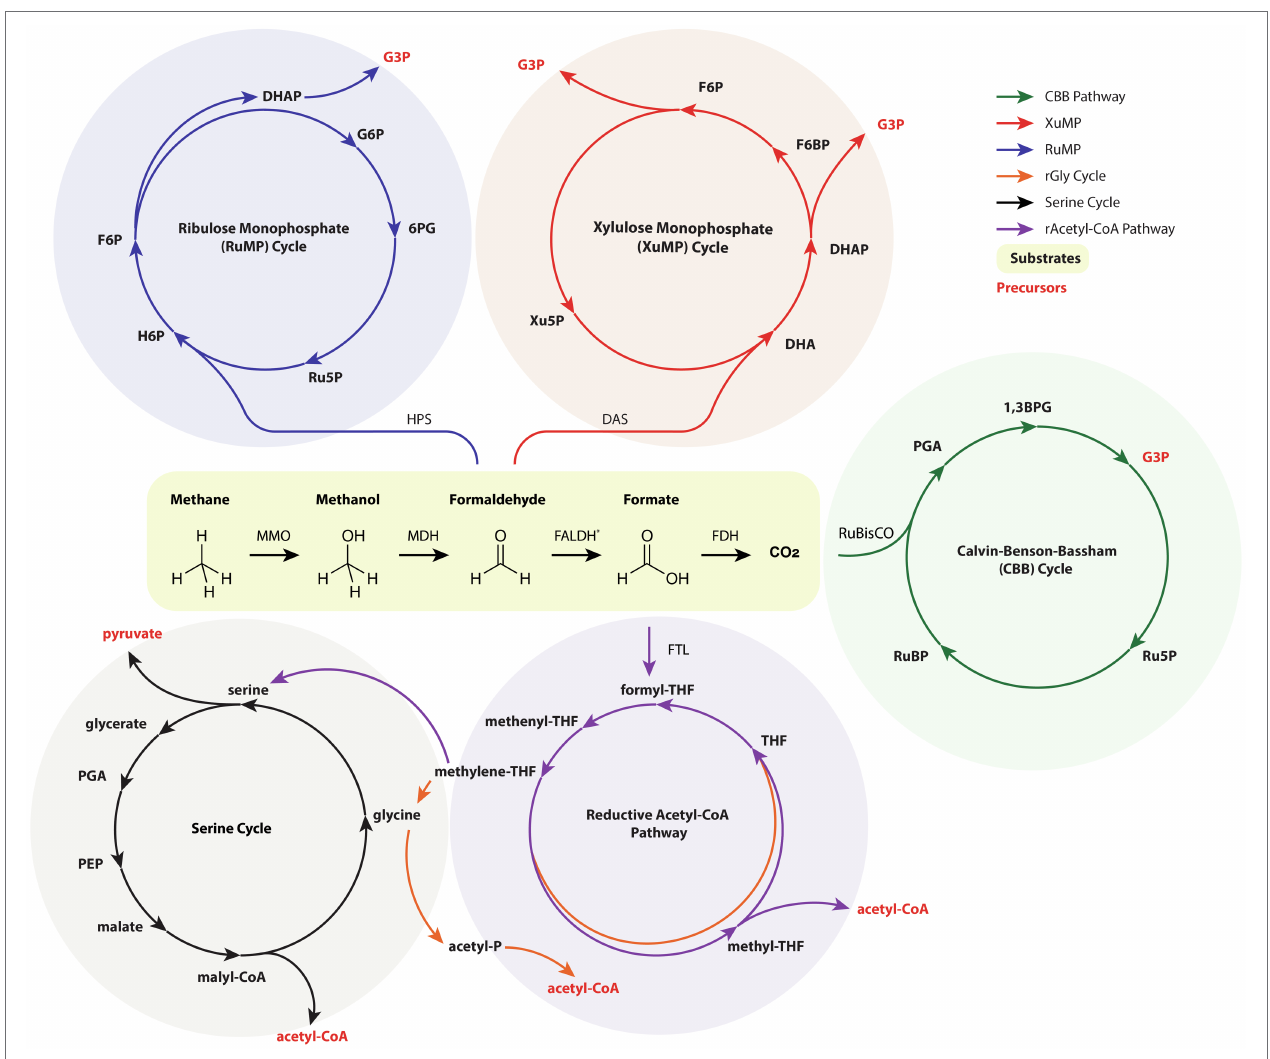
FIGURE 3 | An amalgamated and simplified depiction of relevant C1 metabolic pathways, namely the ribulose monophosphate (RuMP) cycle, the xylulose monophosphate (XuMP) cycle, the Calvin-Benson-Bassham (CBB) cycle, the serine cycle, reductive acetyl-CoA (Wood-Ljungdahl) cycle, and the reductive glycine pathway. Intracycle reactions and conversion of metabolites by glycolysis is not shown. Emphasis is placed on precursors for isoprenoid and central carbon metabolism, namely G3P, acetyl-CoA, and pyruvate. For clarity, only the enzymes involved in the initial C1 assimilation are listed. For simplicity, FALDH is the depicted enzyme for conversion of formaldehyde to formate and the canonical methanogenic reactions are omitted. 1,3BPG, 1,3-bisphosphoglyceric acid; 6PG, 6-phosphogluconate; DAS, dihydroxyacetone synthase; DHA, dihydroxyacetone; DHAP, dihydroxyacetone phosphate; F6BP, fructose 6-bisphosphate; F6P, fructose 6-phosphate; FALDH, formaldehyde dehydrogenase; FDH, formate dehydrogenase; FTL, formate-THF ligase; G3P, glyceraldehyde 3-phosphate; G6P, glucose 6-phosphate; H6P, hexulose 6-phosphate; HPS, hexulose-6-phosphate synthase; MDH, methanol dehydrogenase; MMO, methane monooxygenase; PEP, phosphoenolpyruvate; PGA, 3-phosphoglyceric acid; Ru5P, ribulose 5-phosphate; RuBisCO, ribulose 1,5-bisphosphate carboxylase-oxygenase; RuBP, ribulose bisphosphate; THF, tetrahydrofolate; Xu5P, xylulose